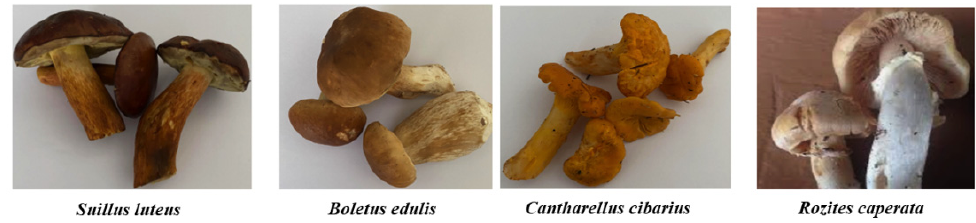
Figure 1. Images of edible mushrooms used in this experiment.